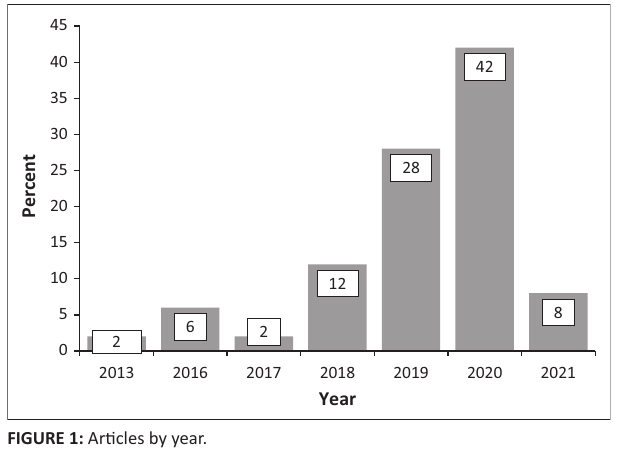
FIGURE 1: Articles by year.